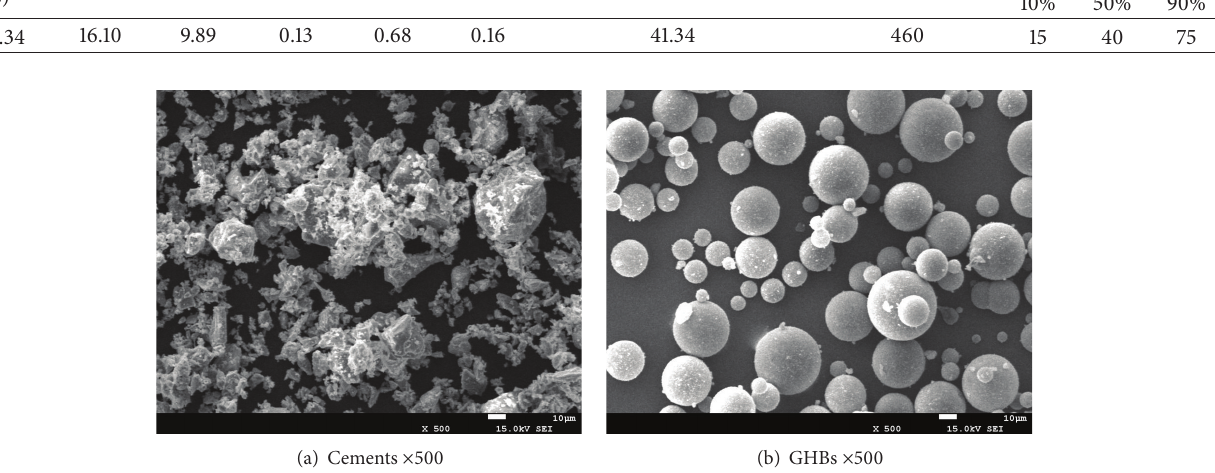
Figure 1: SEM images of the cements and GHBs mentioned.